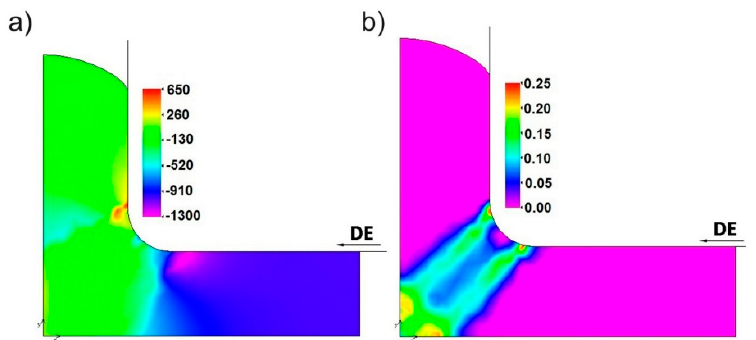
Figure 3. An example distributions of: ( a ) Stress [MPa]—corresponding to Figure 1, and strain rate − 1 ] ( b ) during the 1st pass without back pressure (BP = 0 [s − 1 ] ( b ) during the 1st pass without back pressure (BP = 0 MPa). [s